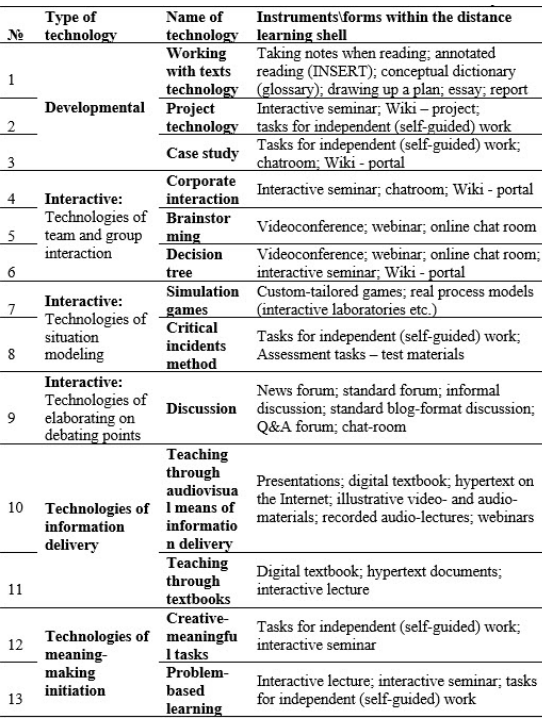
Table 1. Technologies of initiating stu- dents into independent (self-guided) activity in distance